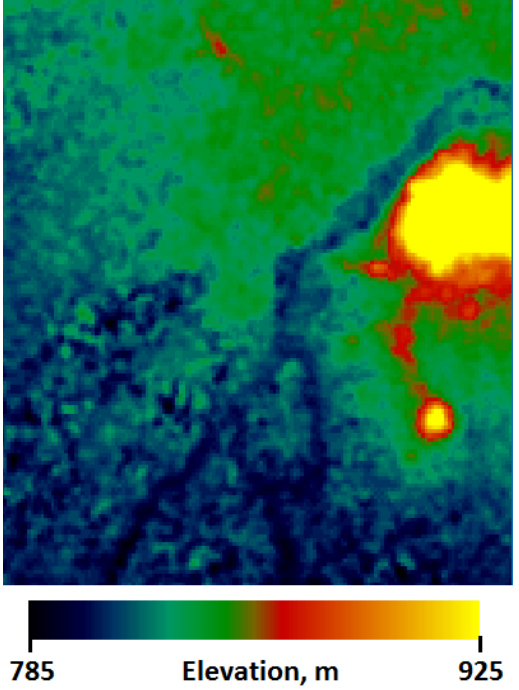
Figure 4. SRTM digital elevation model of the Erfoud town area Coherence data demonstrated high values (0,7-0,9) for all sand- free areas. Due to dynamic elevation changes on sandy